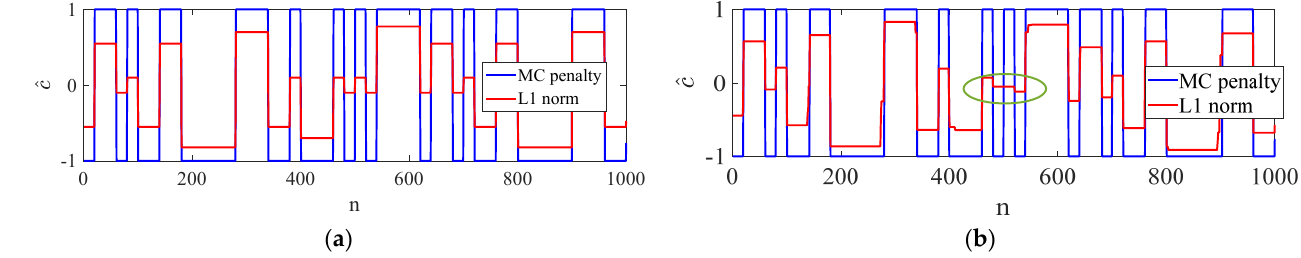
Figure 5. Performance of the MC penalty and L1 norm, ( a ) without noise, ( b )with SNR = − 10 dB. When , the cost function is strongly convex, and (13) can be rewritten as